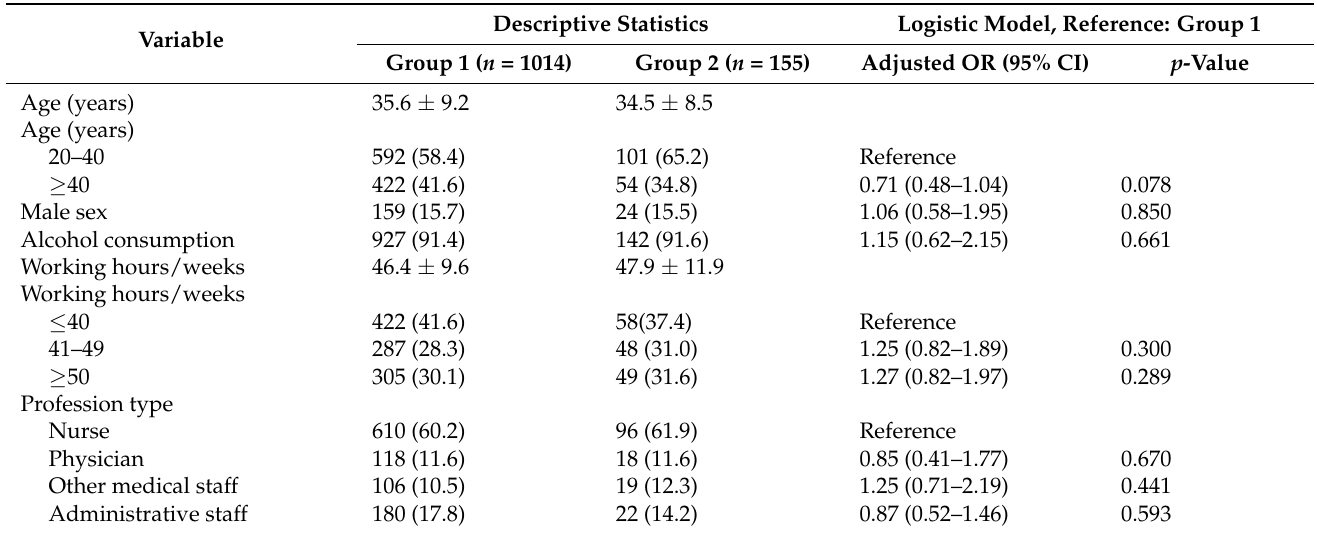
Table 3. Basic demographics of the study population according to the latent classes of developmental trajectories for MHOO in the longitudinal study.